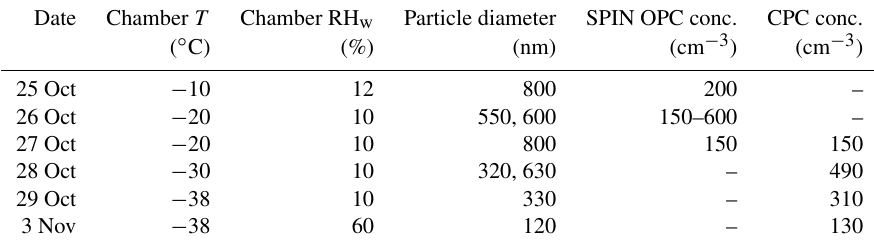
Table 1. The conditions for the ice nucleation experiments with viscous α -pinene SOA. The columns from left to right list the dates when the experiment was carried out, the average temperature in the CLOUD chamber during the particle sampling with the INP counter SPIN, the average relative humidity with respect to water RH w in the CLOUD chamber, mean particle mobility diameters and the sampled particle number concentrations measured by the SPIN optical particle counter (OPC) and a condensation particle counter (CPC). For each experiment, 1 to 4 ice nucleation onset measurements were performed. The CPC was operated parallel to SPIN during half of the runs. For the runs without CPC number concentrations, frozen fractions could be estimated from the SPIN OPC particle number concentrations and size